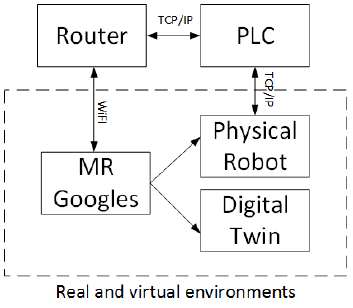
Figure 3. Schematic diagram of the